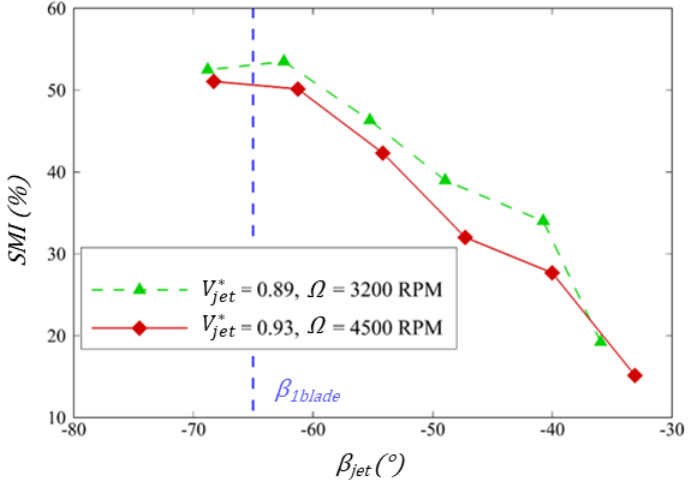
Figure 8. Effect of the relative blowing flow angle with 40 injectors activated at different rotating speeds.